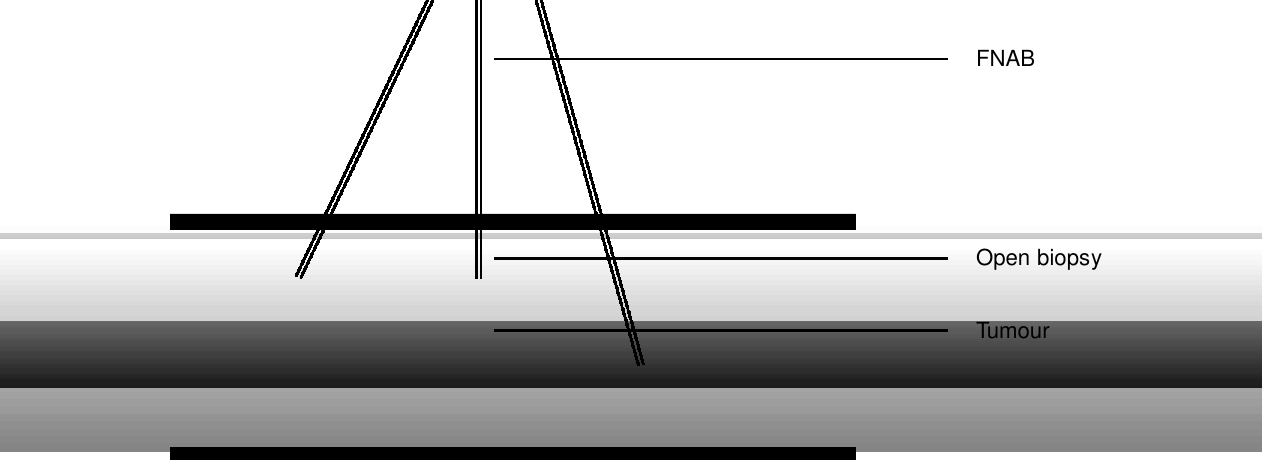
Fig. 3. Open biopsy and FNAB of a bone